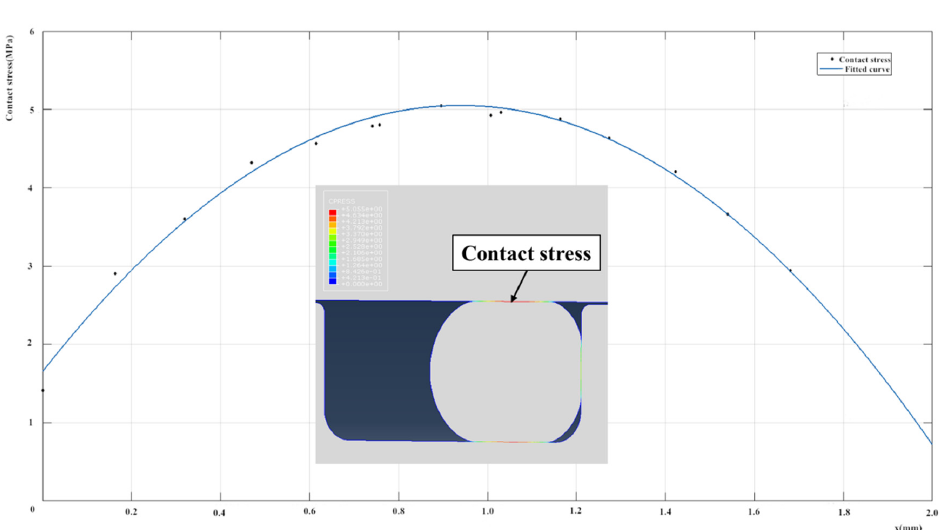
Figure 6. Contact stress distribution of the O-ring. (The x-axis represents the contact width between the O-ring and the cylinder, and x = 0 refers to the first node where the O-ring contacts the inner wall. The y-axis represents the contact stress value at each point.)